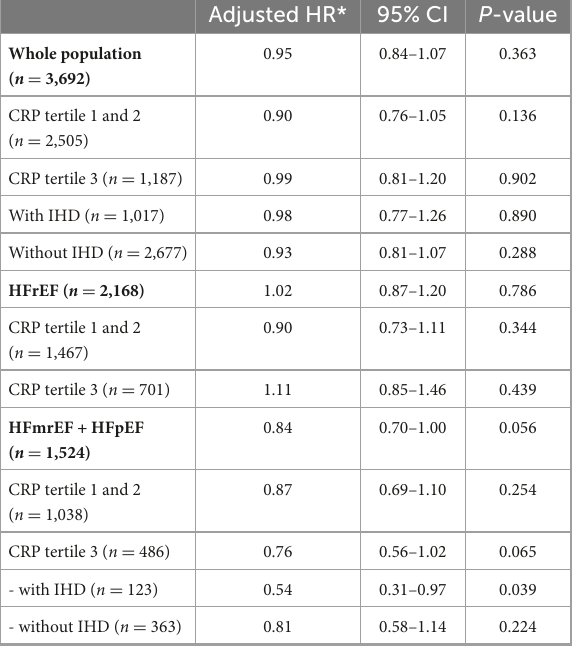
TABLE 3 Risk of all-cause mortality according to statin use (vs.